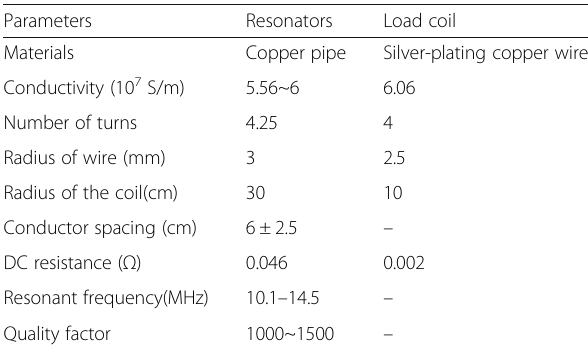
Table 1 Parameters of improved three-coil wireless power link